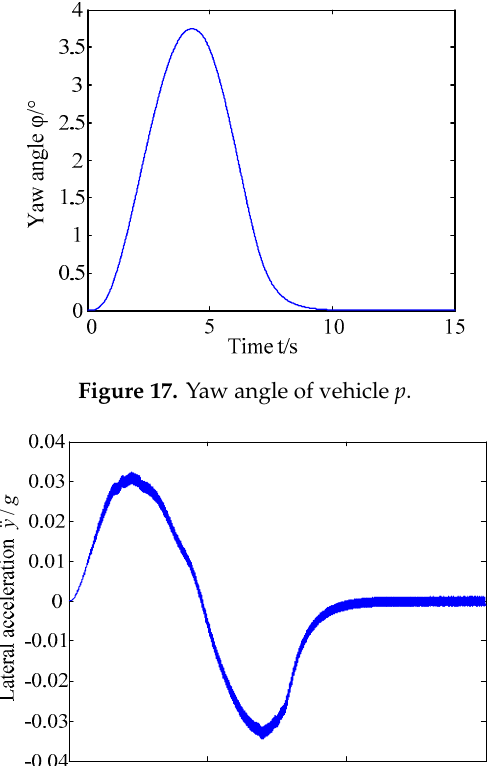
Figure 16. Front wheel steering angle of vehicle p .